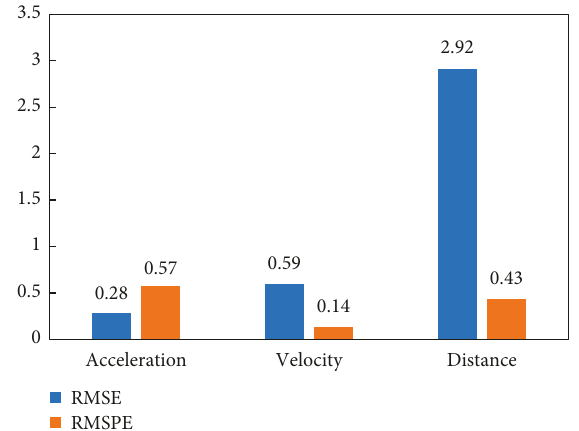
Figure 5: Performance of FVD